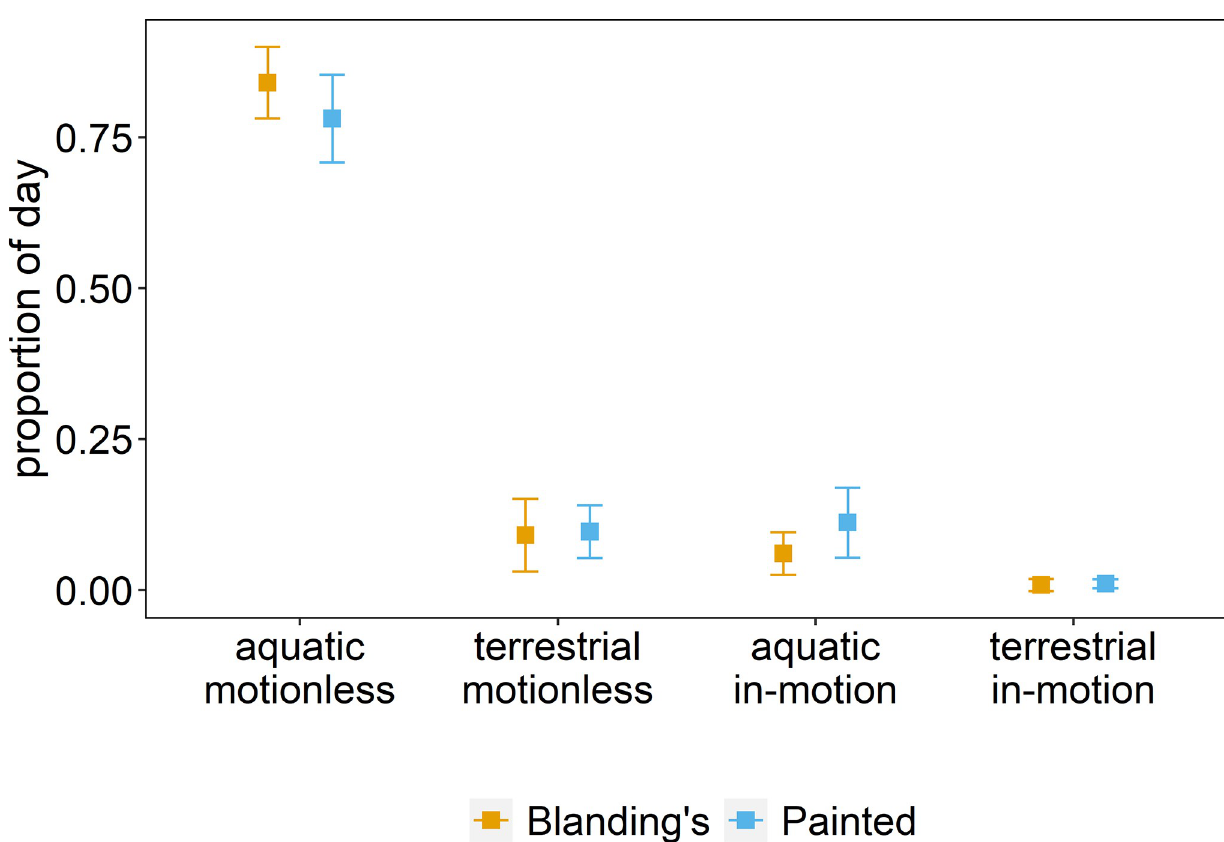
Fig 4. Daily activity-budget for Blanding’s (n = 16) and Painted turtles (n = 23) in the South March Highlands, Ottawa. Shown are mean proportion ( ± SD) of time spent doing each of the four main states during a 24-hour period.